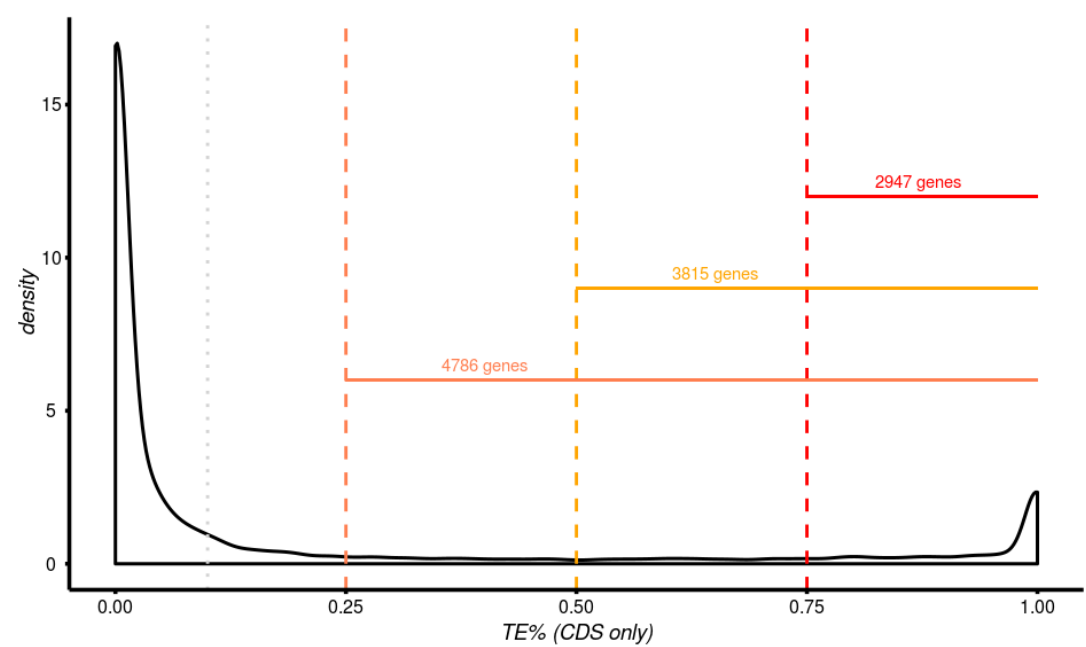
Figure S2. Distribution of the TE content in coding regions observed in the 22,558 Z. borbonicus gene models. The grey line shows the threshold used for identifying the most accurate genes (see Fig. 1).